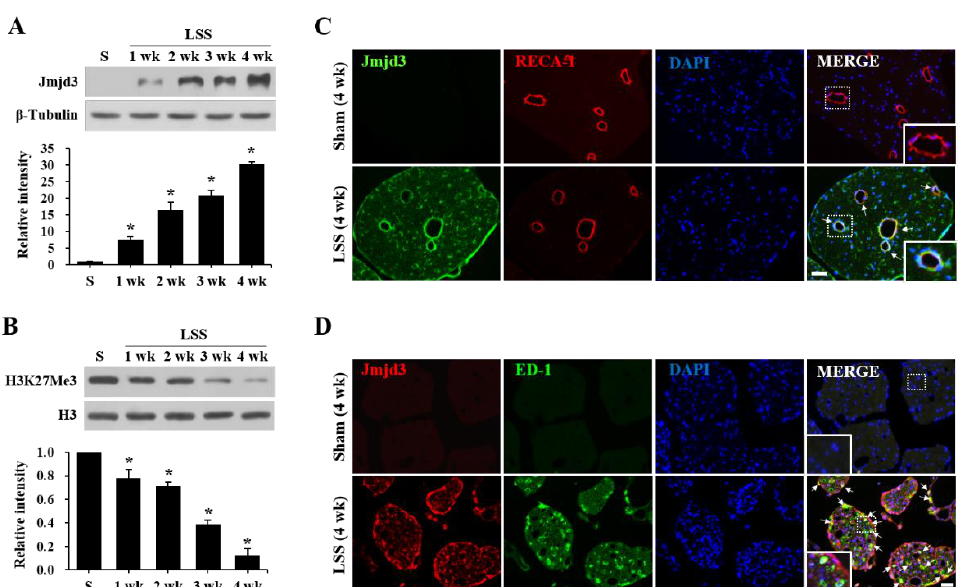
Figure 2. Jmjd3 expression and activation are increased in the cauda equina after compression injury in an LSS model. ( A , B ) Western blot and quantitative analysis for Jmjd3 ( A ) and H3K27Me3 ( B ) in the cauda equina at an indicated time point after the compression injury. The data are presented as the mean ± SD (n = 3). * p < 0.05 vs. Sham (4 weeks). ( C ) Double immunofluorescence staining for Jmjd3 and RECA-1 (endothelial cell marker) in Sham (4 weeks) and injured cauda equina (4 weeks after compression). Arrows indicate double-positive cells. The right, bottom panels show a higher magnification of the boxed area. Scale bar, 50 μm. ( D ) Double immunofluorescence staining for Jmjd3 and ED-1 (macrophage marker) in Sham (4 weeks) and injured cauda equina (4 weeks after compression). Arrows indicated double-positive cells. The left, bottom panels show a higher magnification of the boxed area. Scale bar, 50 μm.